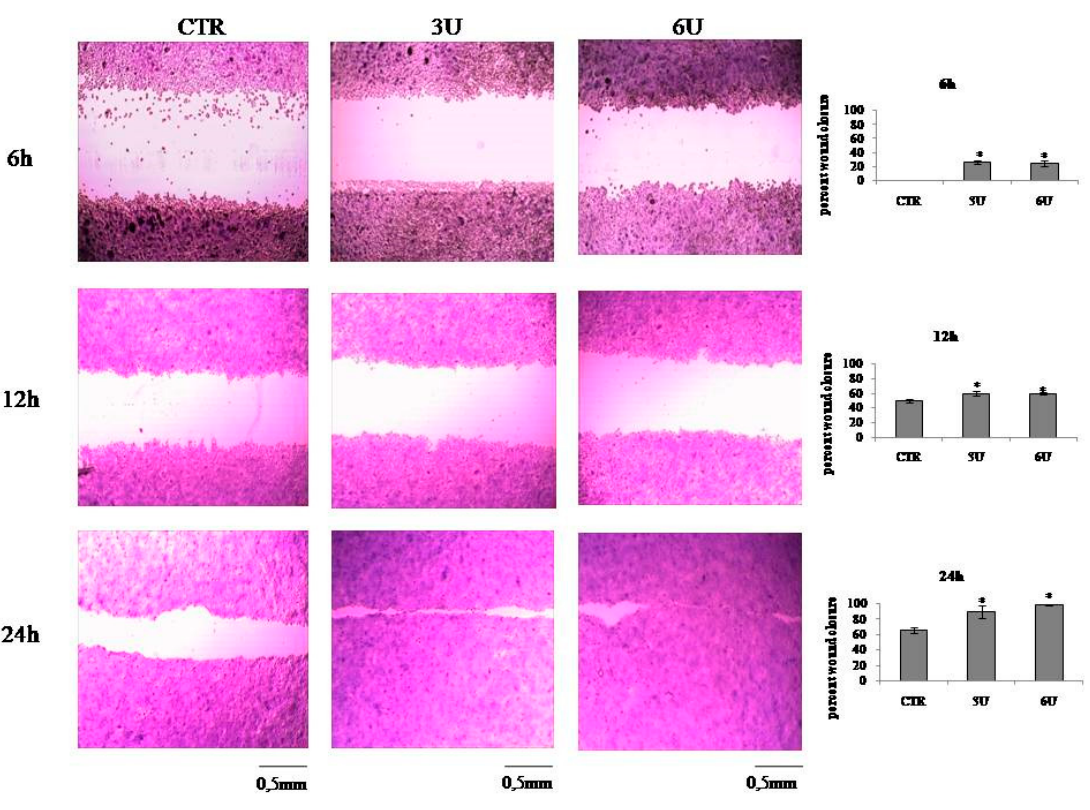
Figure 7. Effect of nSMase in wound closure. HaCaT cells were treated with 3U and 6U nSMase, and wound healing assay was performed after 6, 12, and 24 h. The left figure shows the panel of microscopy images. The right figure shows the percentage of closure. Data are expressed as mean ± SD of three independent experiments performed in duplicate. Significance, * p < 0.001 versus control sample.